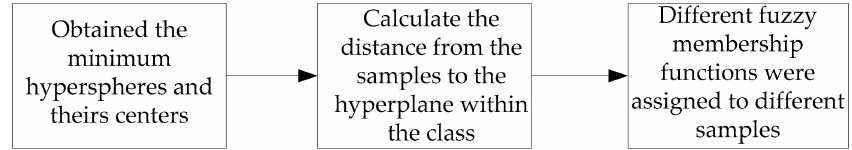
Figure 1. The overview of the proposed